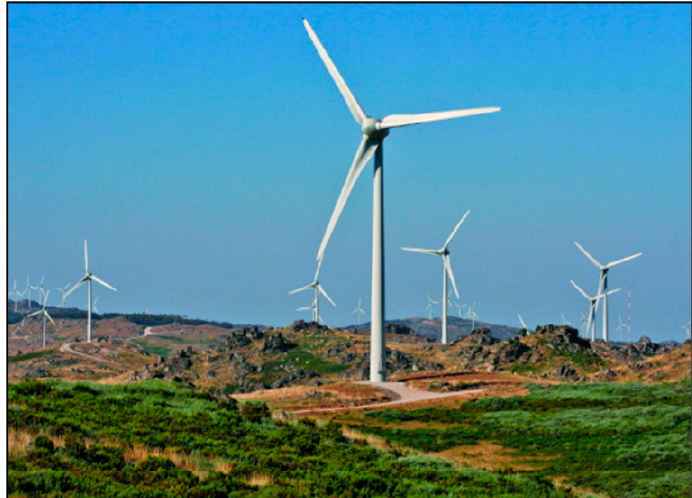
Figure 3. GENERG wind farm in Caramulo (source: Adapted from [9]).